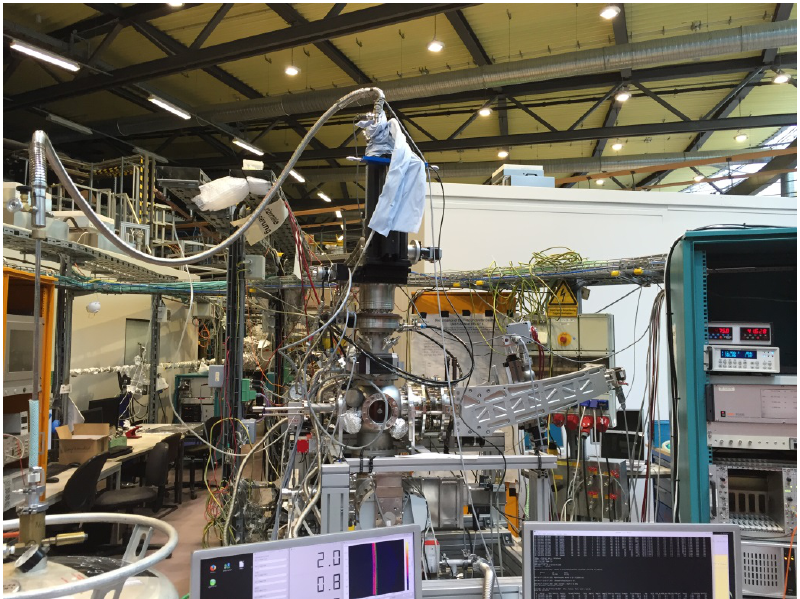
Figure 1: View of the Solid flexRIXS endstation.